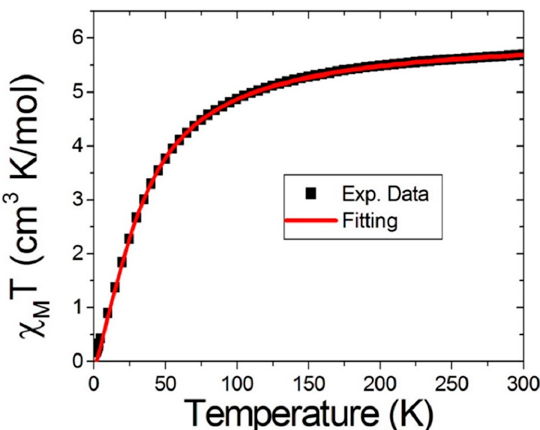
Figure 4. χ M T vs. T plot under a magnetic field of 1000 G in the 2~300 K range for compound 1 . The black square represents the experimental data, and the solid red line is the best fit for the data using Equation (2).